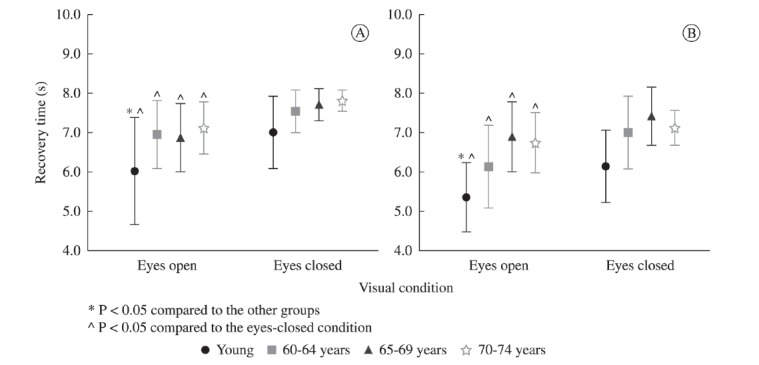
Mean and standard deviation of AP (A) and ML (B) recovery times with
eyes open (EO) and eyes closed (EC) for all of the age groups (young, 60-64,
65-69, and 70-74 years old).